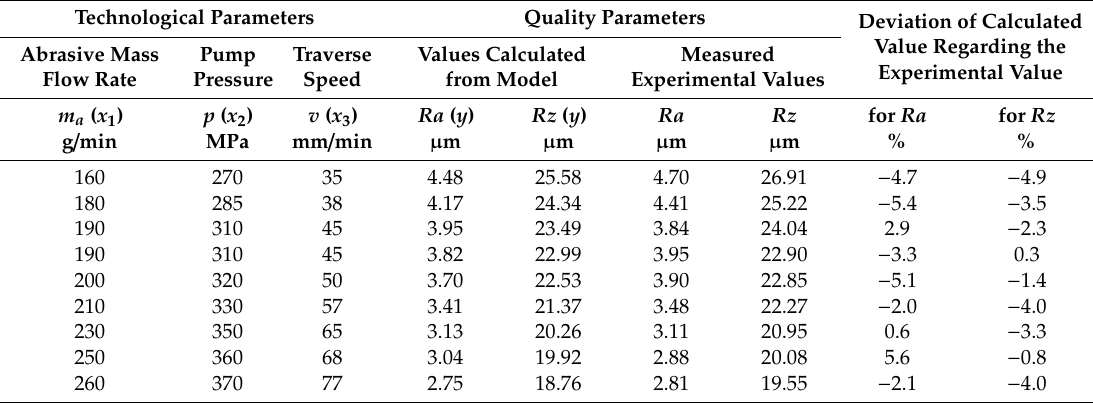
Table 6. Comparison of calculated and measured roughness values Ra and Rz.